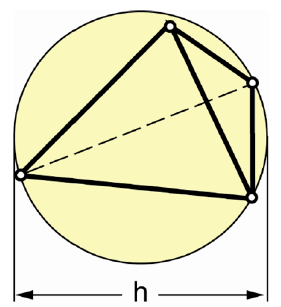
Figure 9. An element in a sphere solution domain.